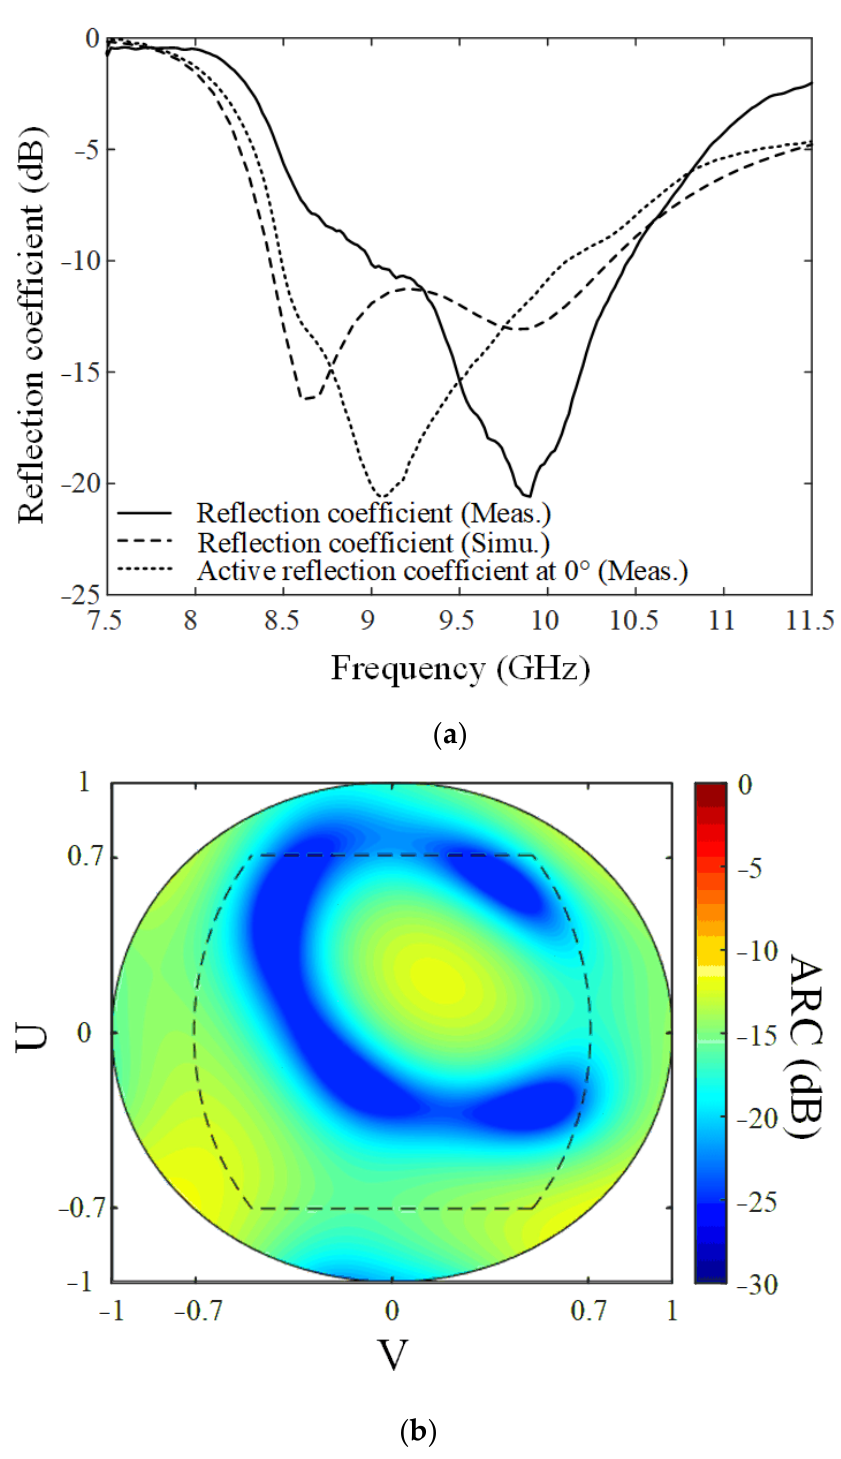
Figure 6. Active reflection co-efficient in X-band: ( a ) comparison between the reflection co-efficients